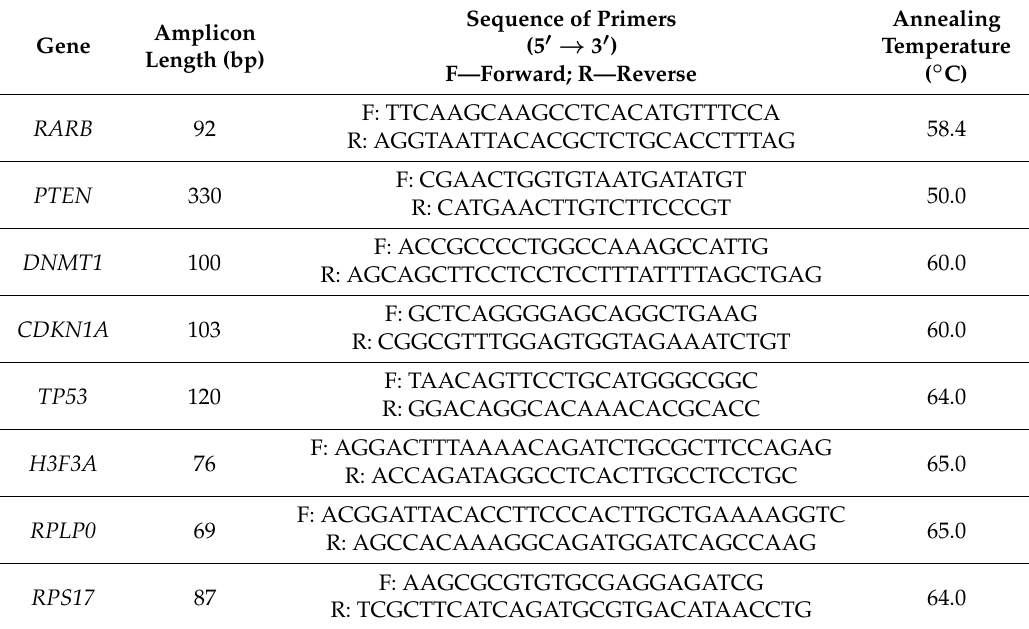
Table 3. Primer sequences, annealing temperature, and PCR product size used for quantitative real-time PCR